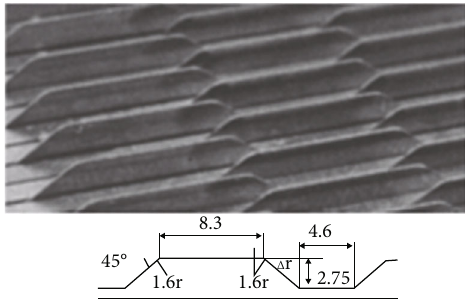
Figure 19: Bionic groove physical picture [89].